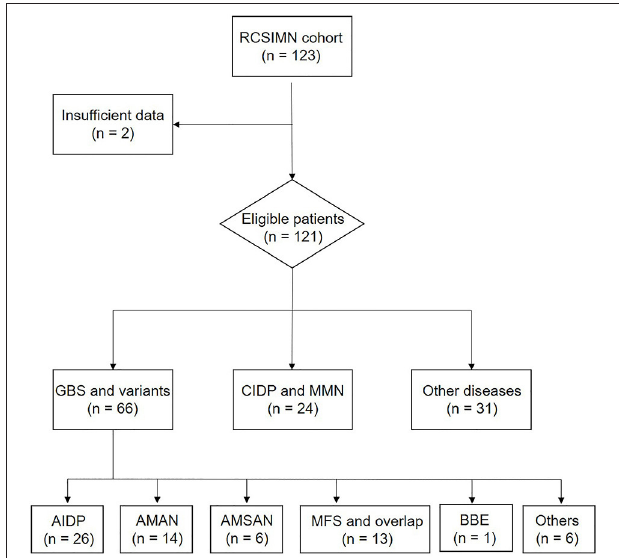
FIGURE 1 | Trial profile. RCSIMN, A Registered Cohort Study of Immune-Mediated Neuropathies; GBS, Guillain-Barre syndrome; CIDP, Chronic-inflammatory demyelinating polyneuropathy; AIDP, Acute inflammatory demyelinating polyradiculoneuropathy; AMAN, Acute motor axonal neuropathy; AMSAN, Acute motor sensory axonal neuropathy; MFS, Miller-Fisher syndrome; BBE, Bickerstaff brainstem